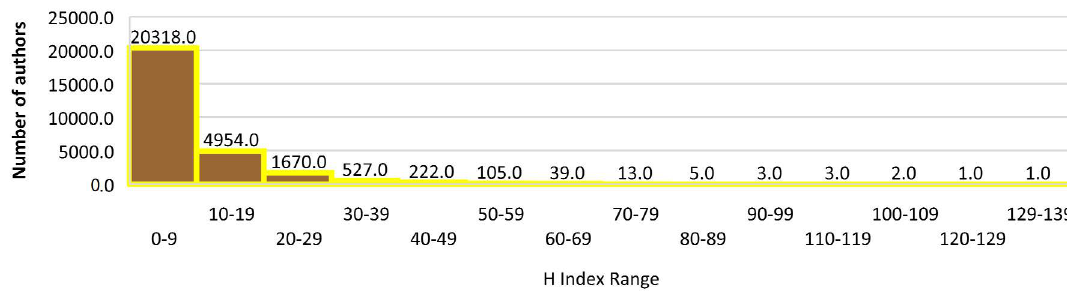
Figure 28. Distribution by H-index. Figure 28 . Distribution by H-index.